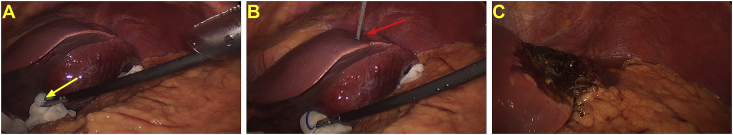
Laparoscopic view of a lesion. A. The pre-operative lesion, with wet gauze was placed between the liver and stomach to avoid surrounding tissue damage caused by the ablation thermal radiation of the ablation (yellow arrow). B. The intra-operative lesions, chosen the normal liver lesions within 0.5–1.0 cm from the edge of the tumour to start ablation (red arrow). C. The post-operative lesion, the lesion became a depressed mass with a hard texture after ablation. (For interpretation of the references to color in this figure legend, the reader is referred to the Web version of this article.)